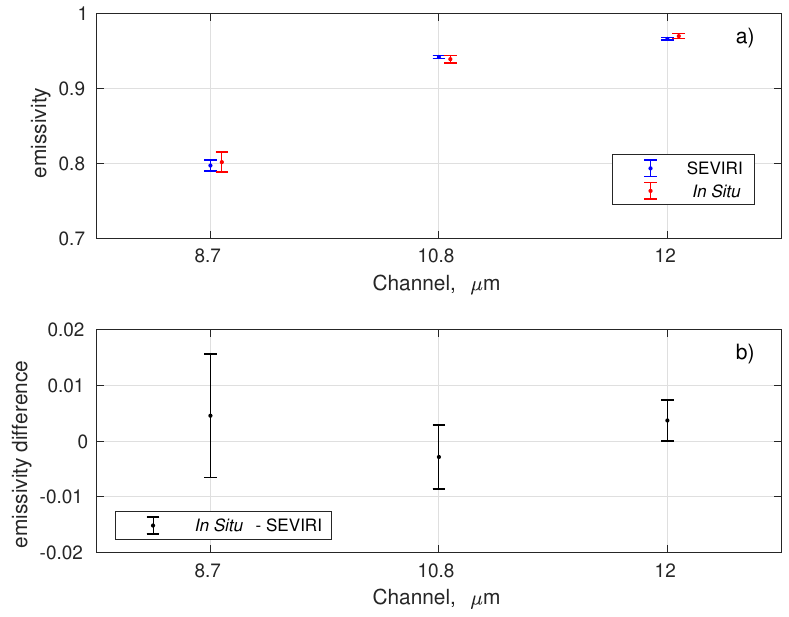
Figure 9. ( a ) Comparison between SEVIRI emissivity and in situ measurements. Error bars represent the standard deviation (variability) of retrievals and in situ measurements. ( b ) Emissivity difference